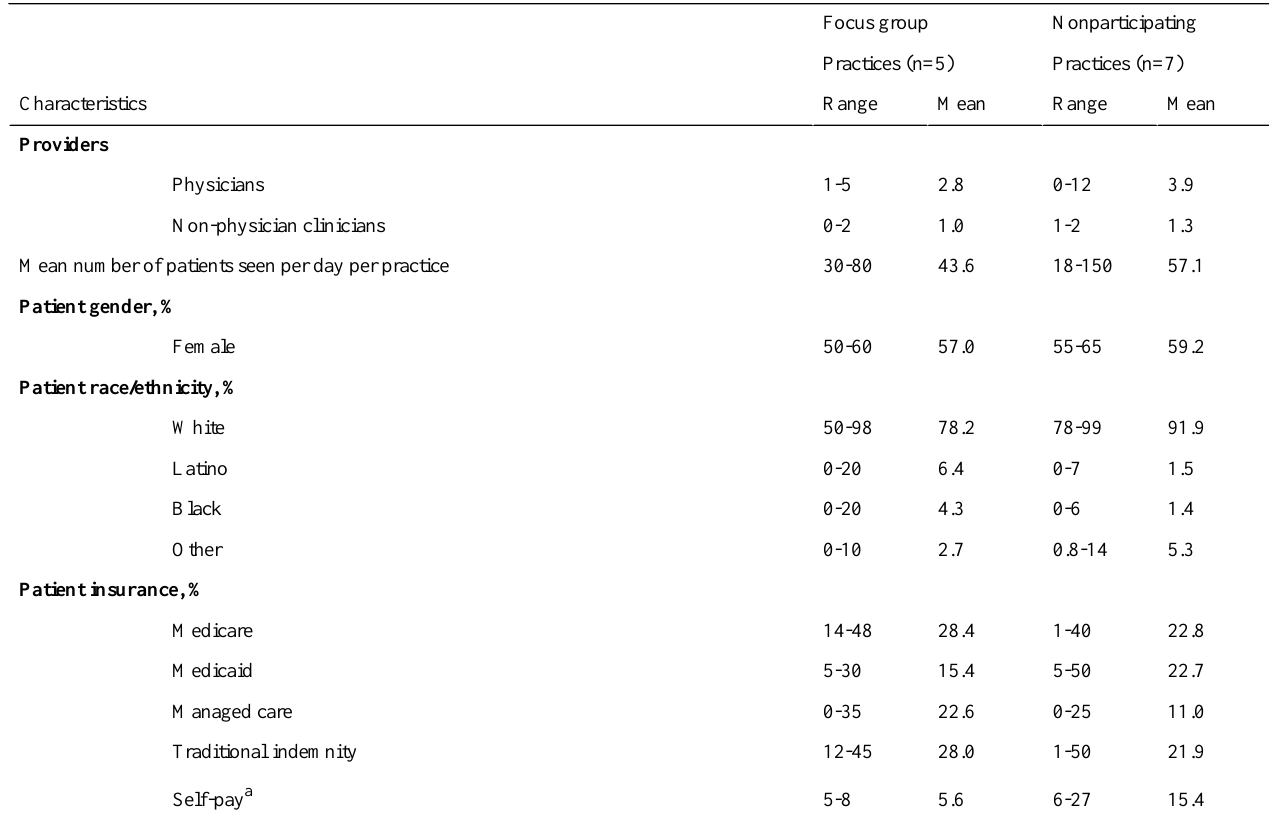
Table 1. Comparison of the focus group sites and non-participating sites.